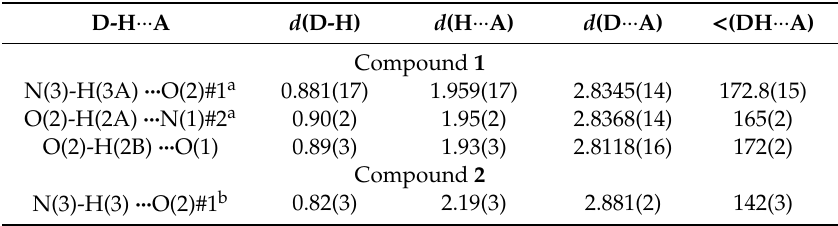
Table 2. Hydrogen bonding geometrical parameters for compounds 1 and 2 (Å, °).